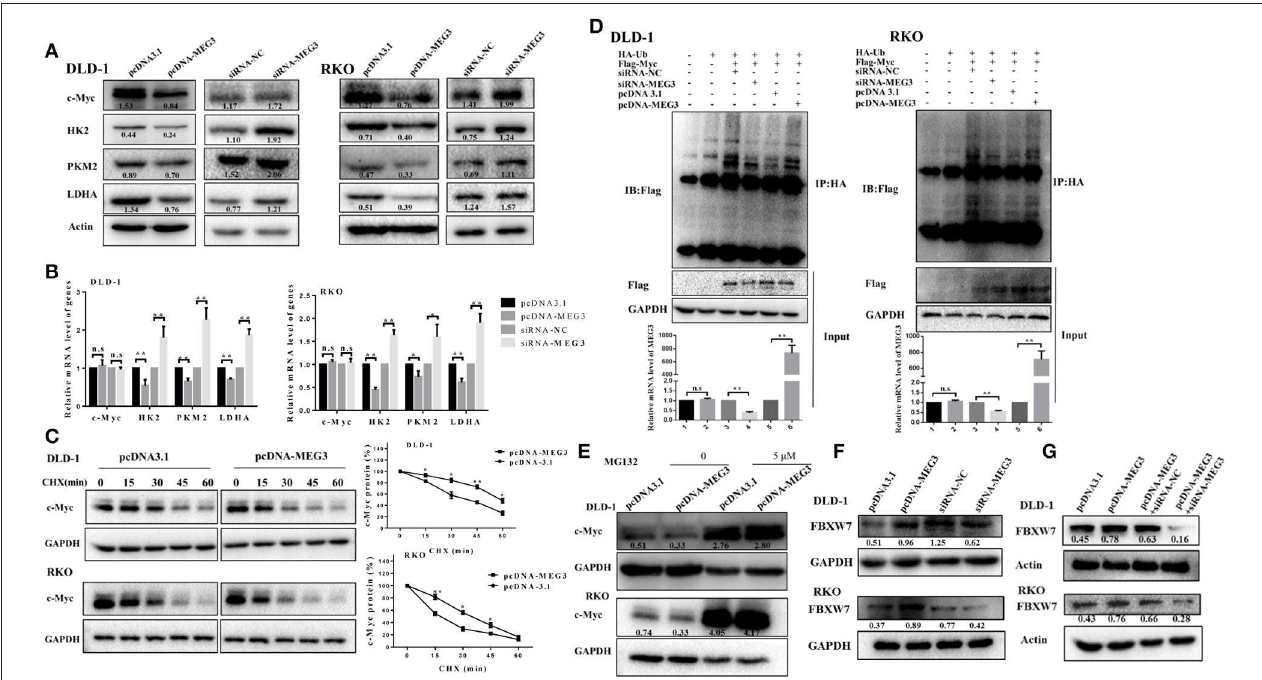
FIGURE 4 | Maternally expressed gene 3 ( MEG3 ) promotes c-Myc protein degradation. Expression levels of c-Myc, HK2, PKM2, and LDHA were detected by Western blot (A) and qRT-PCR (B) analysis in MEG3 overexpression and knockdown colorectal cancer (CRC) cell lines. (C) MEG3 overexpression CRC cell lines were treated with 100 µ g/ml of cycloheximide (CHX) and harvested at the indicated time points. c-Myc protein was detected by Western blot analysis, quantified by densitometry, and plotted against time to determine c-Myc stability. (D) CRC cells were transfected with pcDNA-c-Myc in combination with pcDNA-MEG3 in the presence of the HA-ubiquitin plasmid as indicated at the top. The cells were treated with MG132 (30 µ M) for 6h before harvesting, and the cell lysates were subjected to immunoprecipitation using anti-HA antibody. Ubiquitinated proteins were detected by Western blot with the anti-Flag antibody. (E) CRC cell lines that strongly express MEG3 were treated with 5 µ M of MG132 for 12h, and c-Myc protein was detected by Western blot. (F) Expression of FBXW7 was detected by Western blot in CRC cells that strongly and weakly expressed MEG3 . (G) Level of FBXW7 was measured by Western blot in the pcDNA-MEG3 cells with MEG3 knockdown. Data are expressed as mean ± standard deviation from three independent experiments. * P < 0.05, ** P <